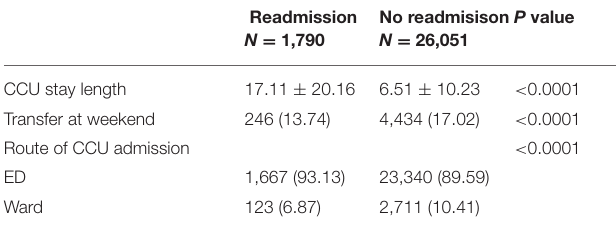
TABLE 1 | Baseline characteristics.